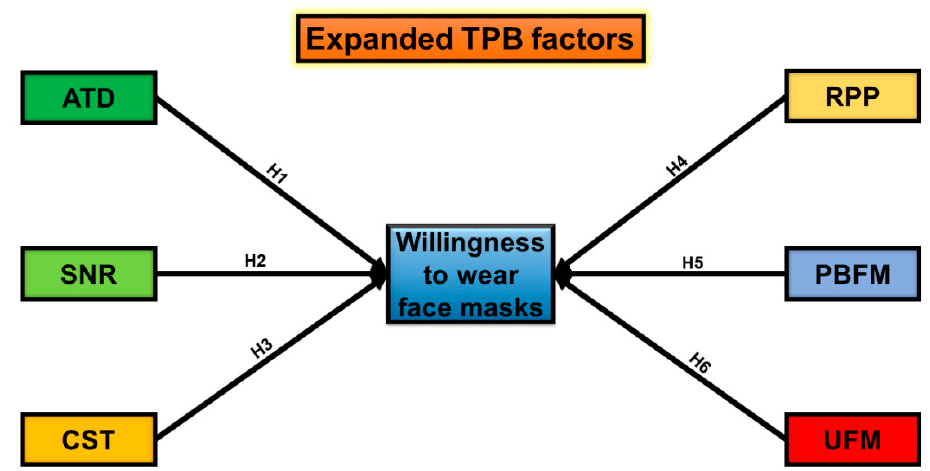
Figure 2. Research framework presenting the influencing factors of public WTW face masks. Notes: ATD: Attitude, SNR: Social norms, CST: Cost of face masks, RPP: Risk perceptions of the pandemic, PBFM: Perceived benefits of face masks. UFM: Unavailability of face masks.